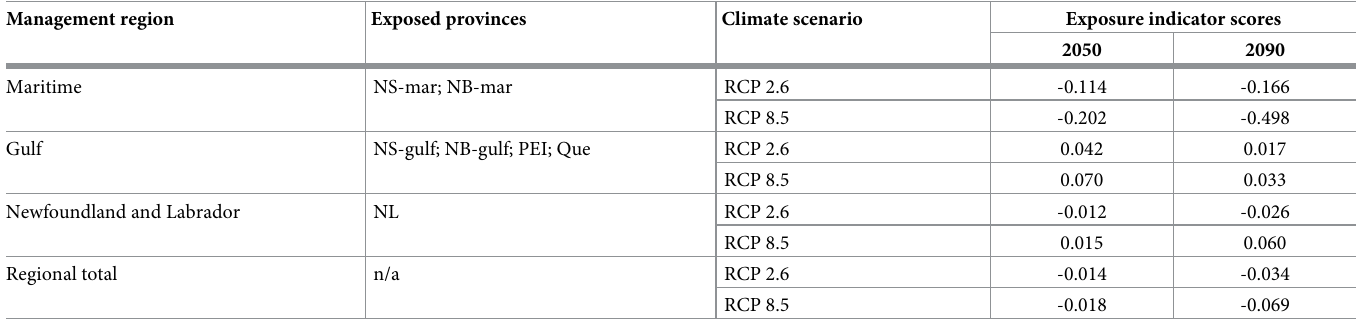
Table 2. Cumulative exposure indicator of future changes in fisheries (before normalisation of values). Values in fourth and fifth columns are the indicator scores (i.e., the relative change in landings scaled by proportional value of the individual species). For integration into the impact index, the exposure scores were reversed and then normalised to score between 0 and 1, so that declines in landings earned a high score and implied a high exposure to OA and climate